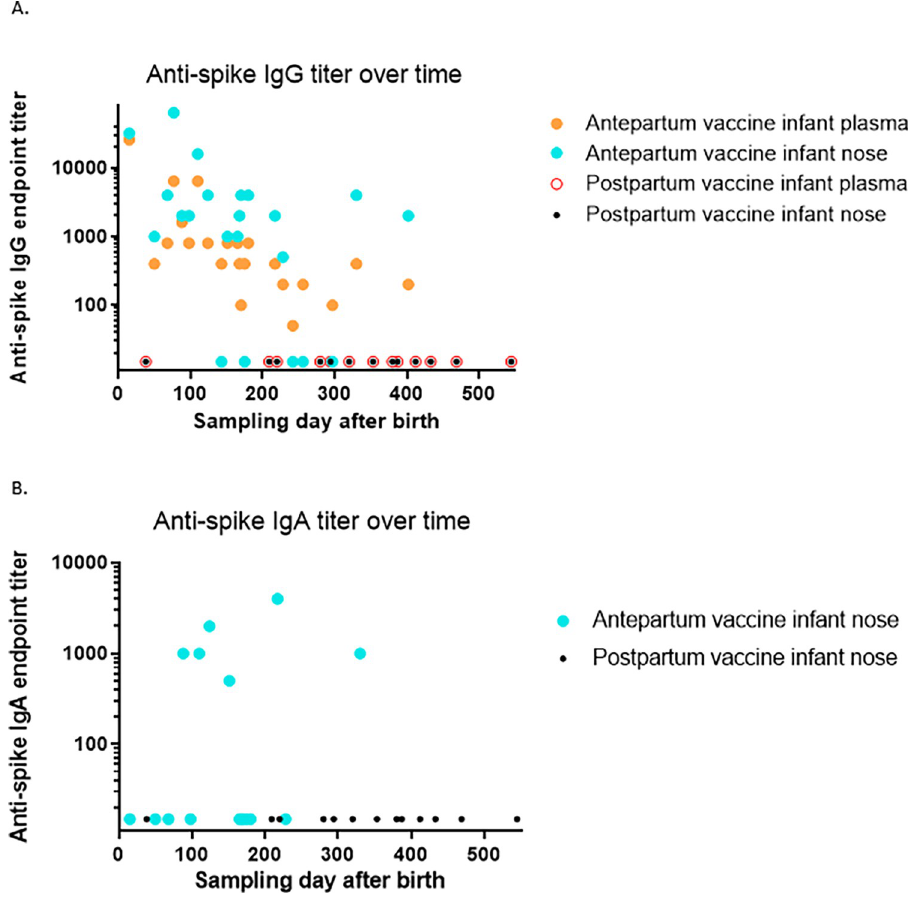
Fig 3. Infant antibodies to SARS-CoV-2 spike antigen over time. A) Infant plasma and nasal anti-spike IgG log transformed and plotted (Y-axis) vs sampling day (X-axis). Samples below the limit of detection were given an arbitrary value of 15. B) Infant nasal anti-spike IgA log transformed and plotted (Y-axis) vs sampling day (X-axis). Samples testing negative were given an arbitrary value of 15. Nasal anti-spike IgG and IgA endpoint titers are reported here as direct results (without providing a ratio with total nasal IgG or